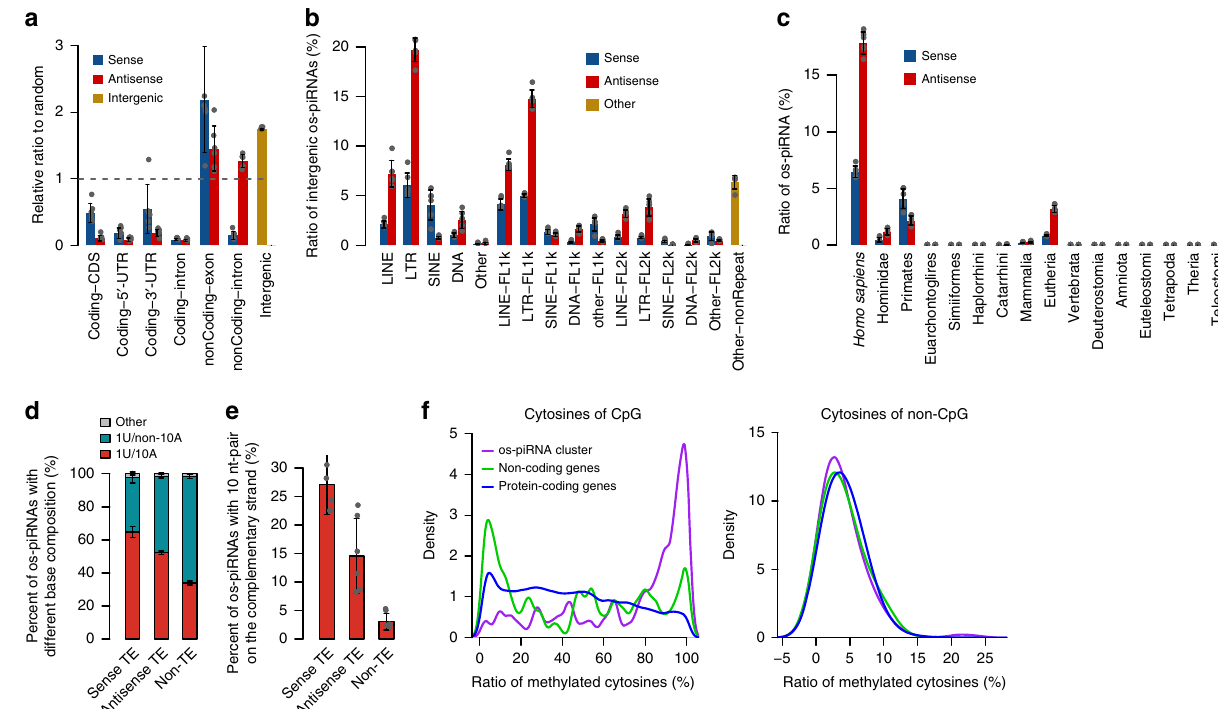
Fig. 4 Potential function of oocyte short-PIWI-interacting RNAs (os-piRNAs). a Enrichment of human os-piRNAs in different gene elements compared to the random genomic distribution. b Proportion of intergenic os-piRNAs on the sense and antisense strand of different transposable elements (TEs) and their fl anking regions. FL1k and FL2k represent the 0 – 1- and 1 – 2-kb fl anking regions, respectively. c The proportion of os-piRNAs on the sense and antisense strand of transposons is classi fi ed according to their evolutionary origin. d The ratio of reads with both 1U and 10A in os-piRNAs derived from sense TEs is greater than those from antisense TEs or non-TE regions. e os-piRNAs derived from sense TEs contained more 10 nt pairs on the complementary strand. Average results in the six replicate samples of human oocytes are shown for a – e , and the error bars represent the standard deviation. f The density plot of the CpG and non-CpG methylation ratios of os-piRNA clusters, protein-coding genes, and non-coding genes. Source data of a – f are provided in the Source Data fi